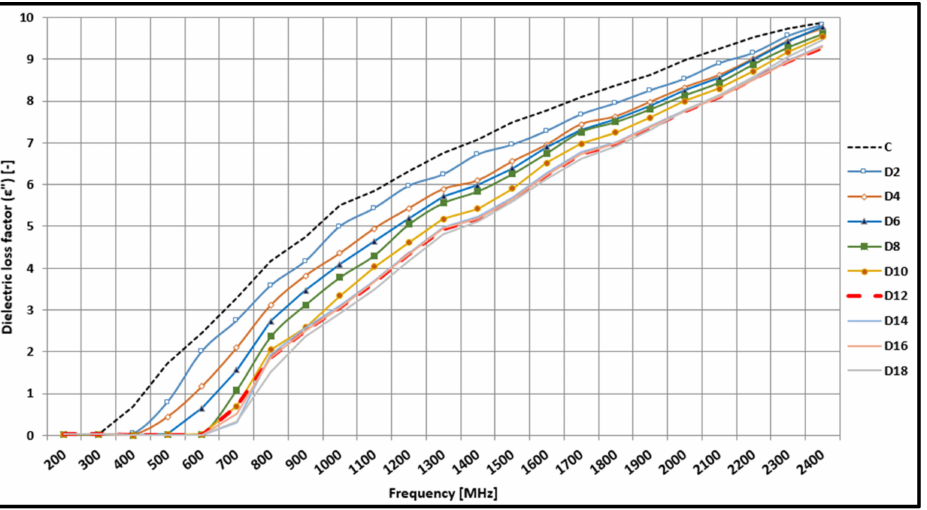
Figure 12. Trends of the dielectric loss factor during the fermentation of the MW-treated